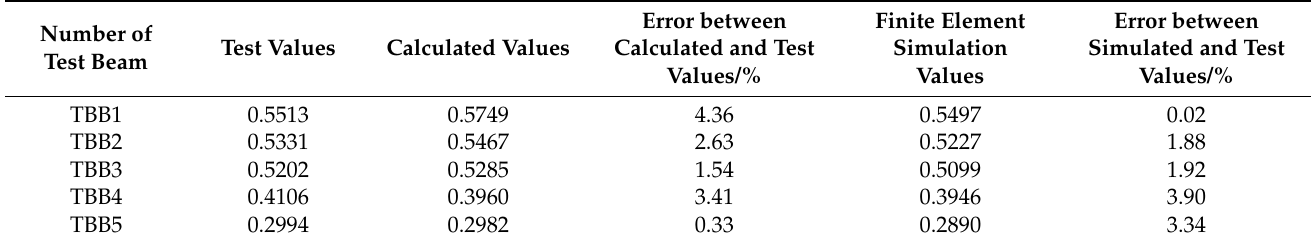
Table 11. Comparison of creep value at 180